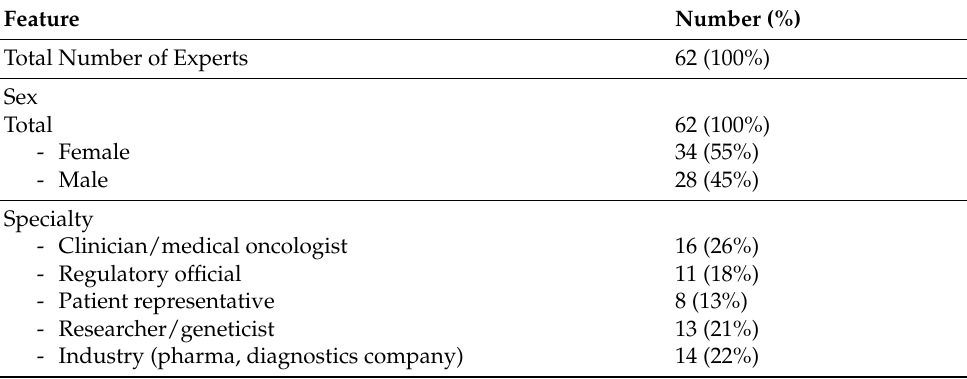
Table A1. Characterization of experts involved in the first round table during April/May/June 2022 held